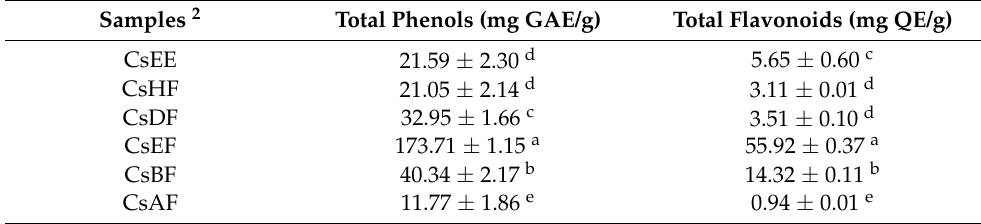
Table 1. Total phenolic and flavonoid contents of Calystegia soldenella extracts and fractions 1 .